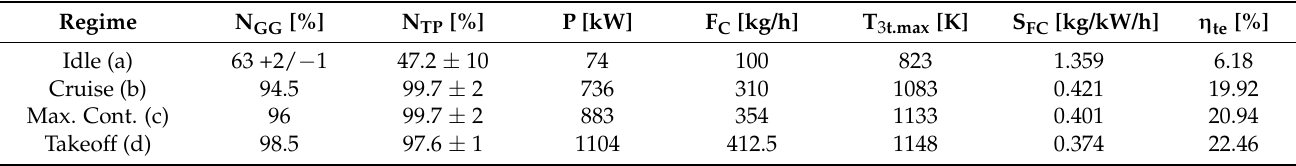
Table 8. TV2-117A operating regimes.